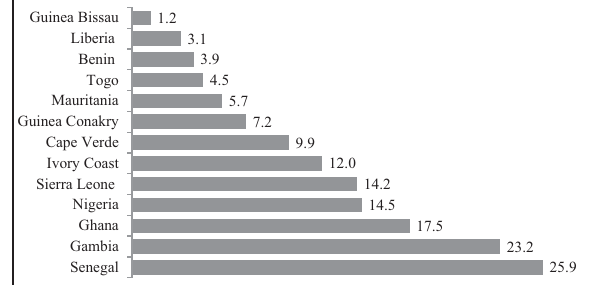
Fig. 1. Average per capita fi sh consumption in the coastal West African countries